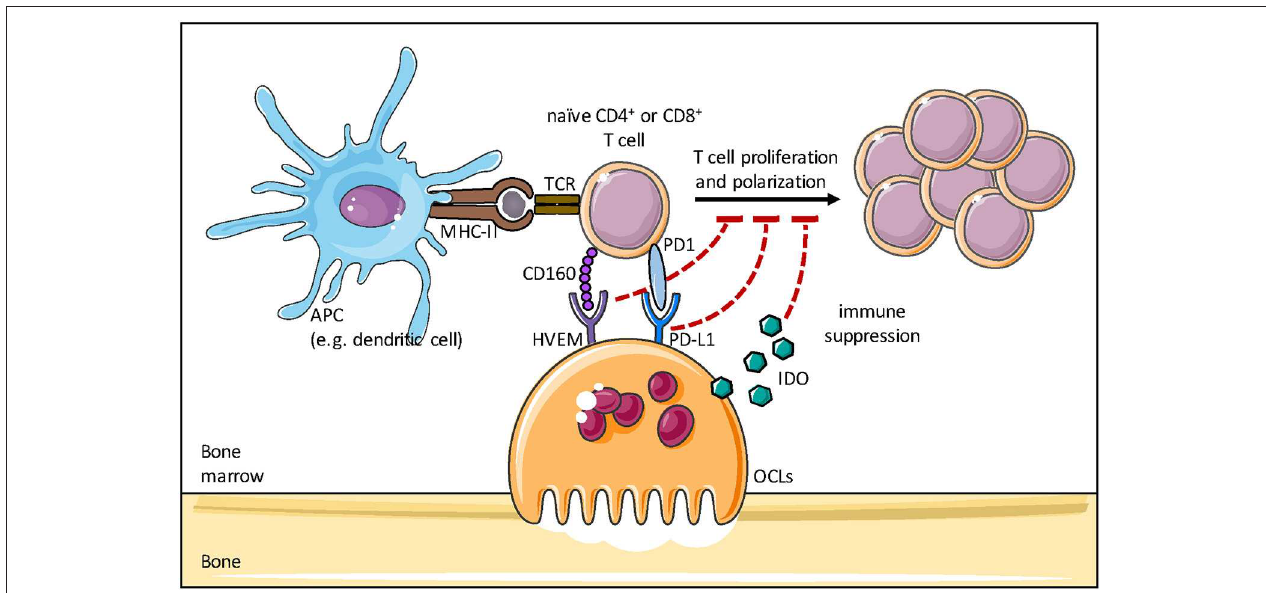
FIGURE 5 | Osteoclasts and immune modulation. Osteoclasts are able to induce an immunosuppressive microenvironment by upregulating inhibitory checkpoint molecules such as programmed death ligand 1 (PD-L1), herpes virus entry mediator (HVEM) and Indoleamine 2,3-dioxygenase (IDO), thereby inhibiting the proliferation and polarization of naive T cells induced by antigen presenting cells (APCs).